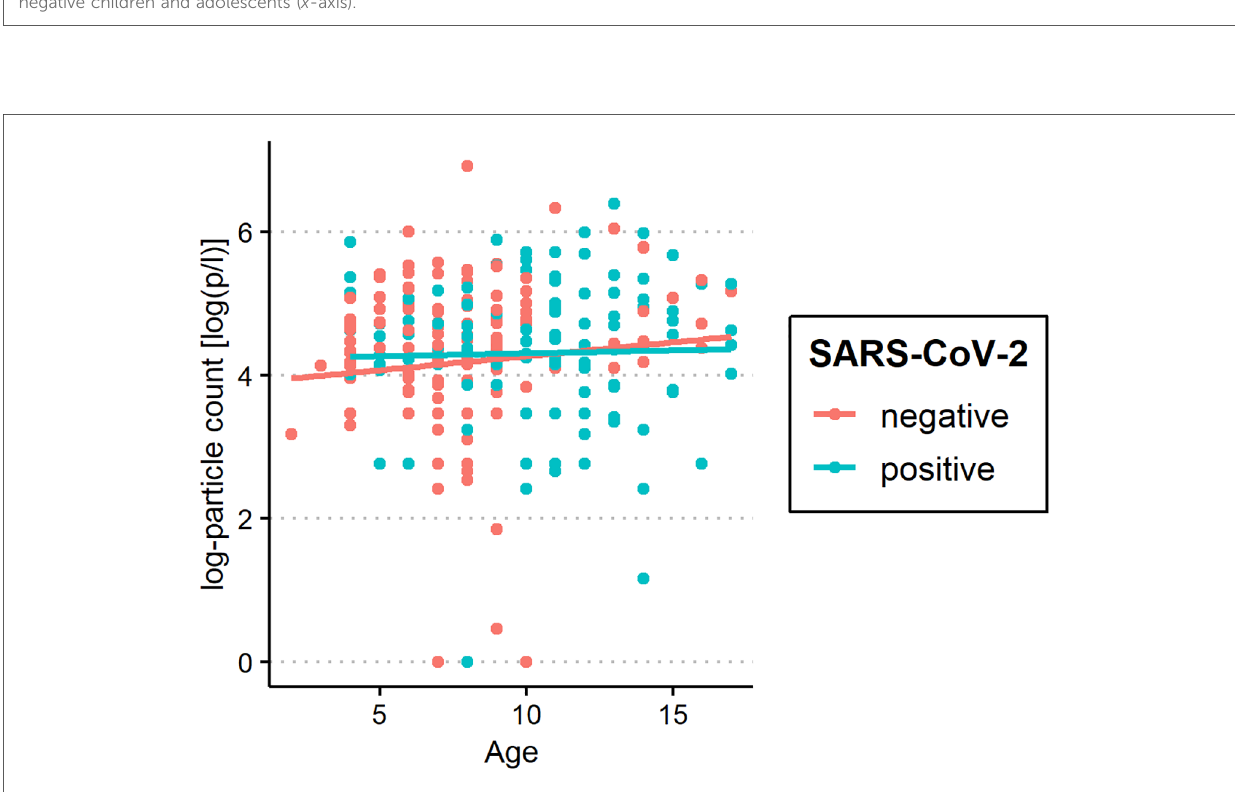
FIGURE 4 Aerosol measurement in relation to age among severe acute respiratory syndrome coronavirus 2 (SARS-CoV-2) polymerase chain reaction (PCR)-positive and PCR-negative subjects. Exhaled particle counts (in particles/liter, displayed on a logarithmic scale, y -axis) in SARS-CoV-2 PCR-positive and PCR- negative children and adolescents displaying the relation to age ( x